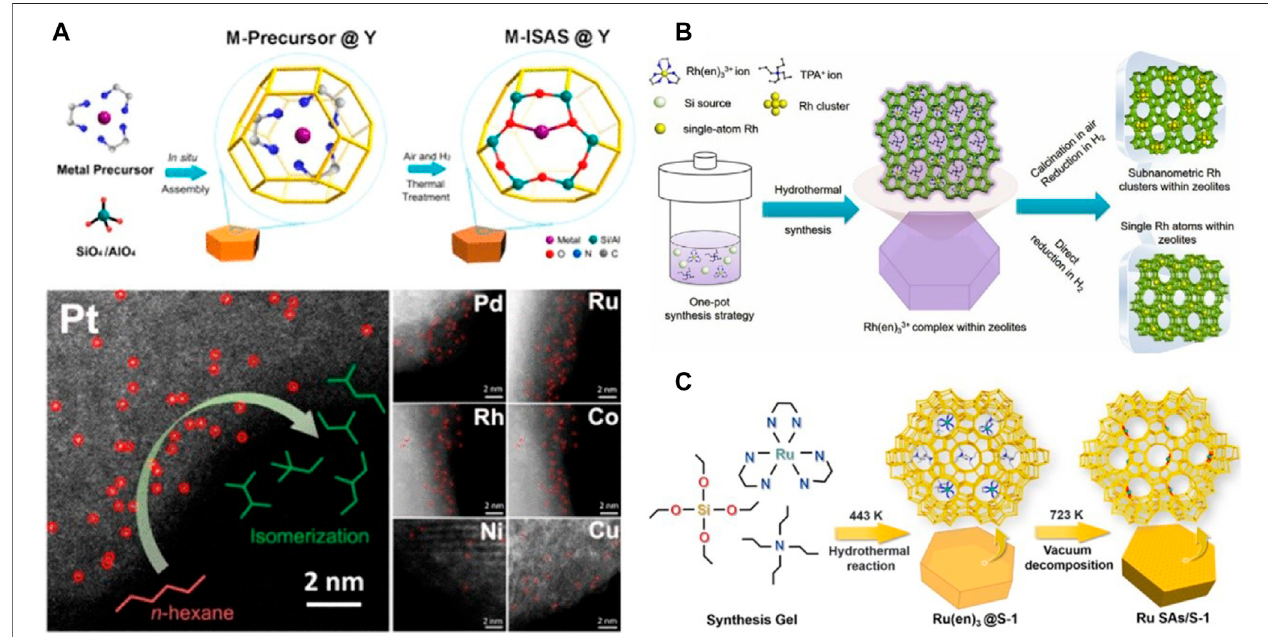
FIGURE 2 | Schematic illustration synthesis and characterization of SACs. (A) In situ separation and con fi nement of a metal precursor in a β -Cage and characterizationofM-ISAS@Y(LiuY.etal.,2019).Copyright2019,AmericanChemicalSociety. (B) SchematicillustrationofthefabricationoftheRh@S-1catalysts(Sun et al., 2019). Copyright 2019, Wiley (C) Synthesis Procedure of Ru SAs/S-1 (Qiu et al., 2019). Copyright 2019, American Chemical